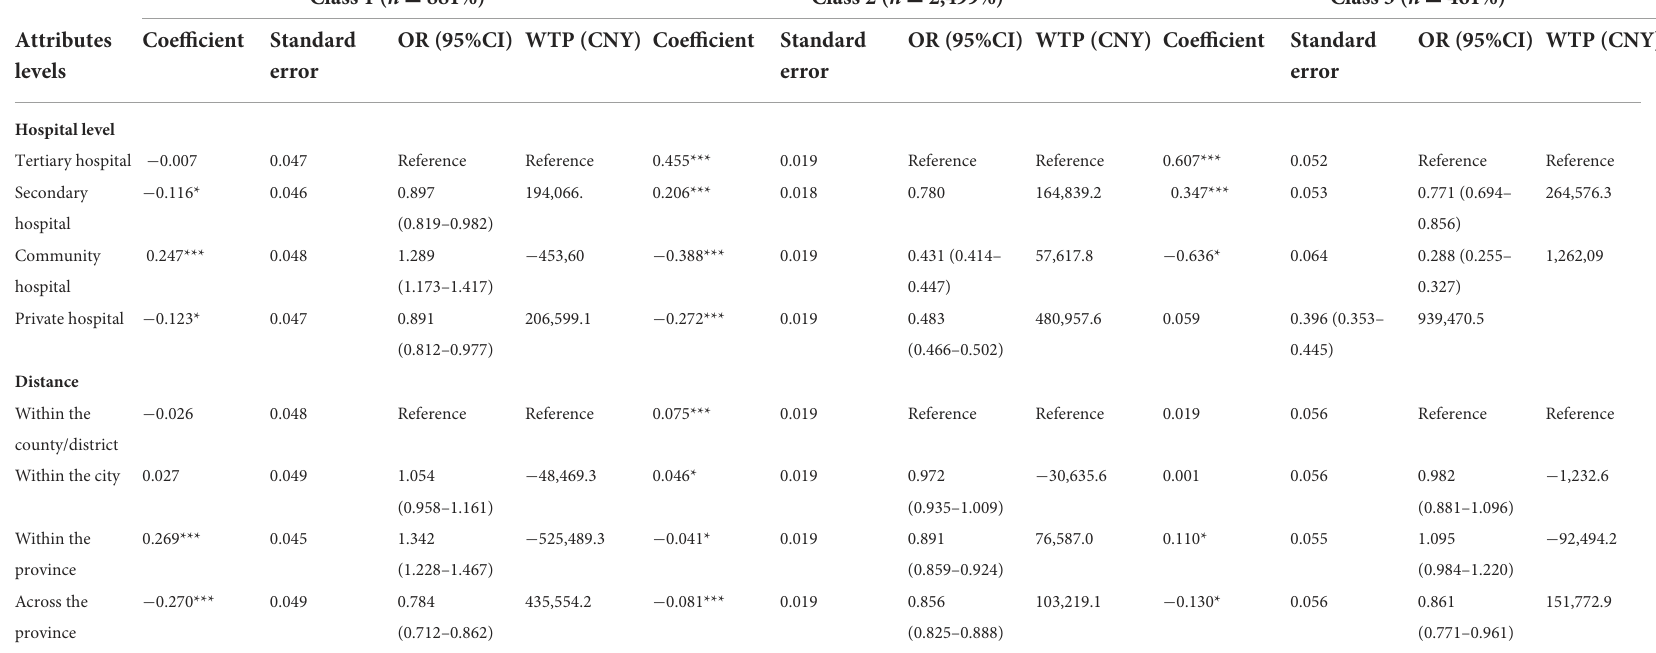
TABLE 10 Attributes and levels of major diseases